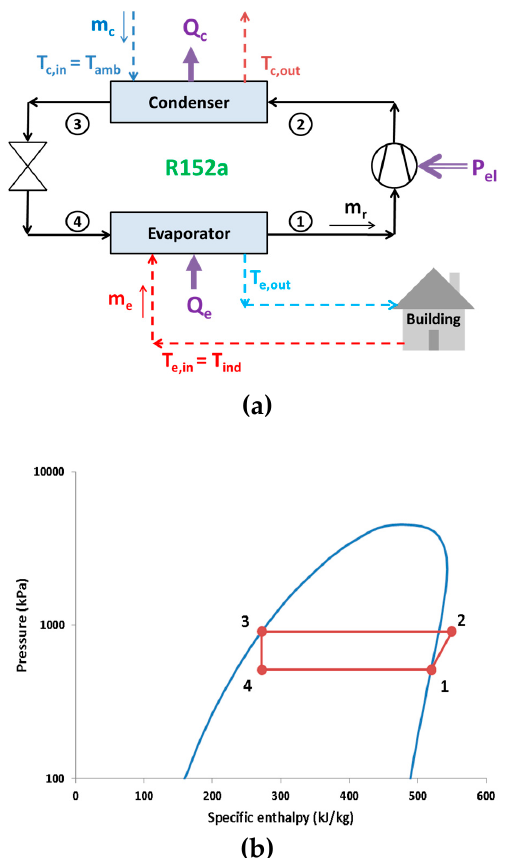
Figure 1. ( a ) The examined cooling system. ( b ) The p-h diagram of the thermodynamic cycle.